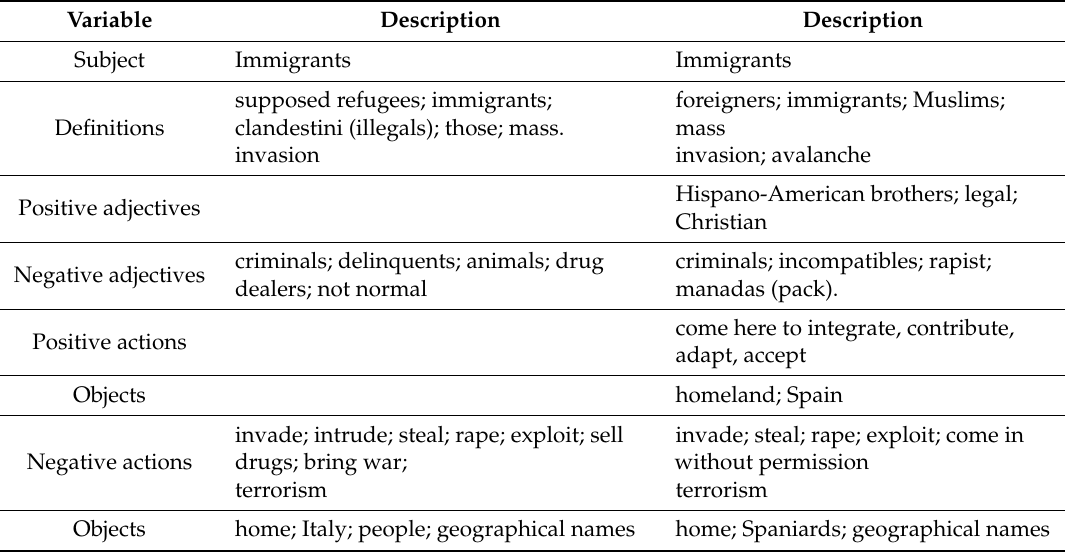
Table 2. The main “them” actor: